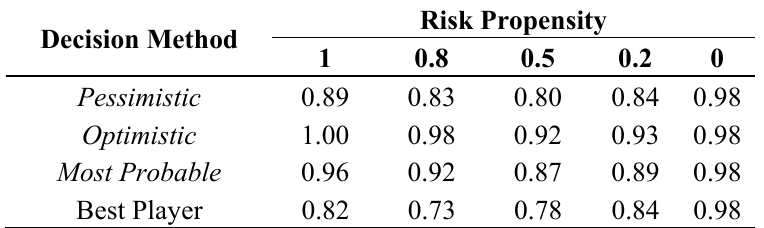
Table 4. Utility function values for different risk propensity values, considering 37 competitor